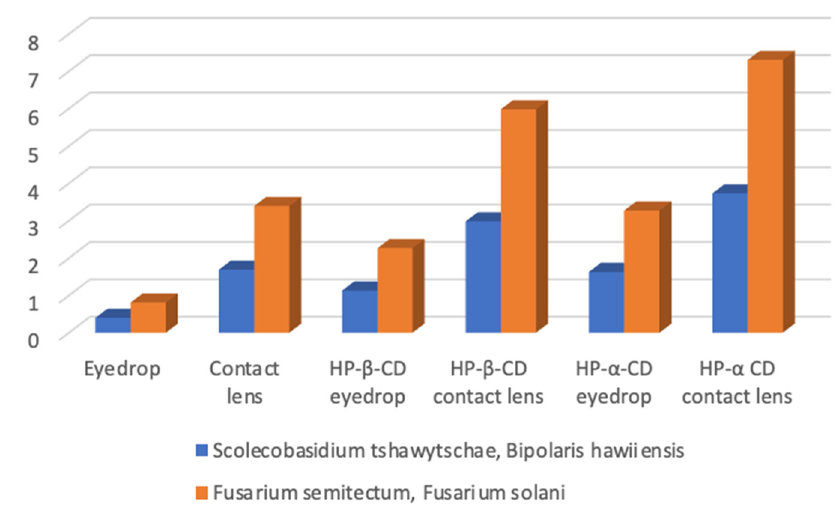
Figure 6. Efficacy of different platforms for the delivery of econazole to the cornea in relation to the MIC of econazole against four fungal species associated with fungal keratitis, where 1 = MIC (the MICs of Scolecobasidium tshawytschae and Bipolaris hawaiiensis were the same, as were those of Fusarium semitectum and Fusarium solani ). Eye drops generally delivered sub-MIC levels, whereas HP- α -CD delivered 3.5–7.1 ×